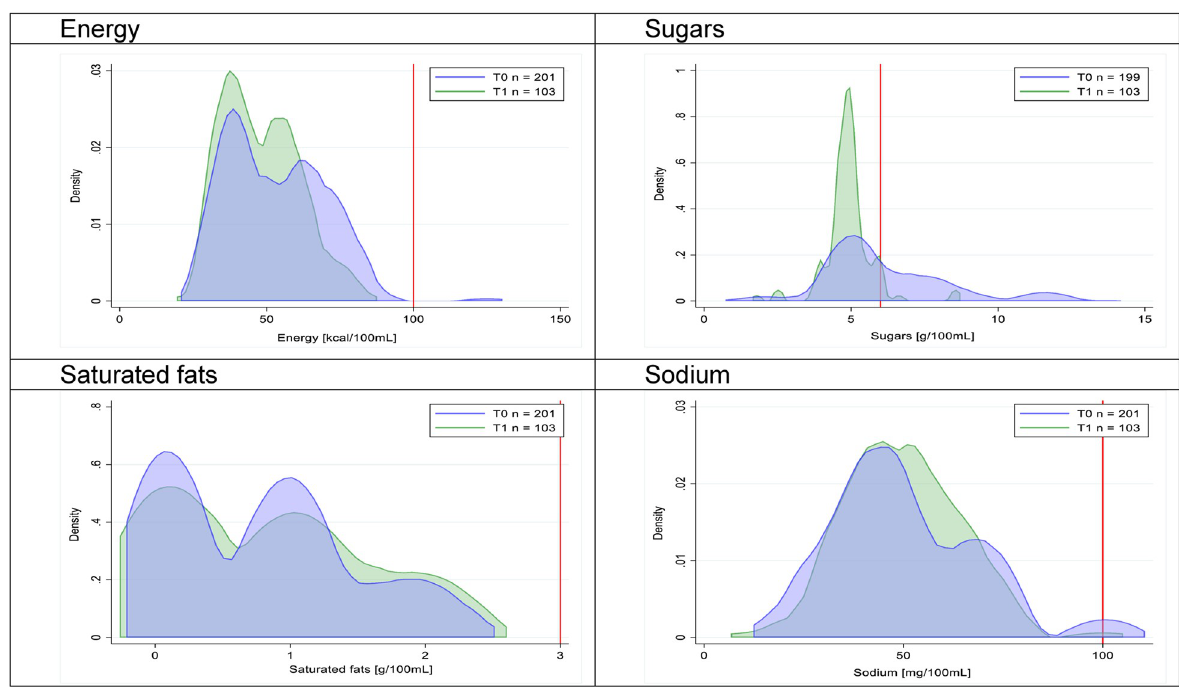
Fig 3. Density curves for the amount of energy and nutrients of concern in milk and milk-based drinks, cross-sectional samples. The blue line represents the distribution in T0 (preimplementation), the green line represents the distribution in T1 (postimplementation), and the red line represents the cutoff for the amount of energy or nutrients of concern.